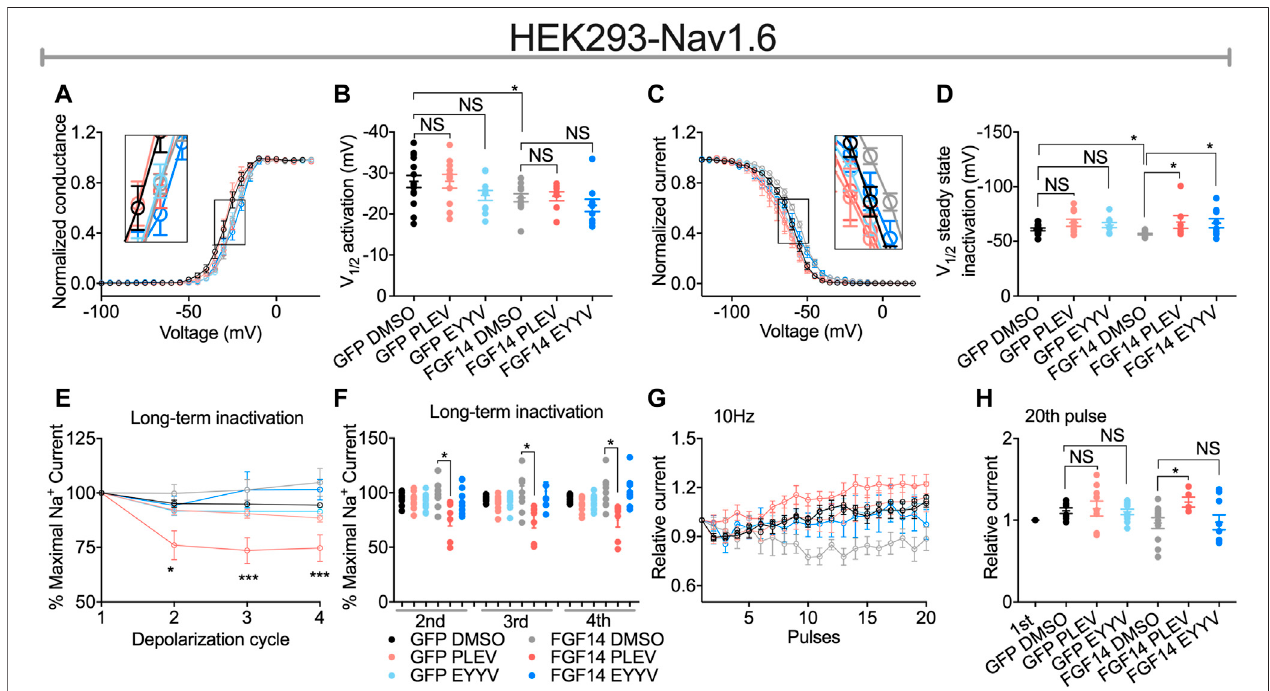
FIGURE 4 | Functional regulation of Nav1.6-mediated currents by PLEV and EYYV. (A) Conductance-voltage relationships for Nav1.6 cells co-expressing GFP or FGF14-GFP treated with 0.1% DMSO, 50 µM PLEV and 50 µM EYYV. (B) Comparison of V1/2 of activation between the indicated experimental groups. (C) Normalized currentasafunctionofmembranepotentialtocharacterizetheeffectsof0.1%DMSO,50 µMPLEV,and50 µMEYYVonsteady-stateinactivation. (D) ComparisonofV1/2of steady-state inactivation between the indicated experimental groups. (E) Ratio maximal INa plotted as a function of depolarization cycle to characterize the effects of 0.1%DMSO,50 µMPLEV,or50 µMEYYVonentryofNav1.6channelsintolong-terminactivation(LTI)inthepresenceandabsenceofFGF14.Cellsweresubjectedtofour 0 mV 16 ms depolarizations separated by − 90 mV 40 ms recovery intervals. (F) Bar graph represented 2nd, 3rd, and 4th pulse of LTI. (G,H) Characterization of cumulative inactivationofNav1.6channelsinthepresenceorabsenceofFGF14exposedto0.1%DMSO,50 µMPLEV,or50 µMEYYV.Itwasexaminedbyapplyinga2 mstestpulse to − 10 mV, 20 times at frequency10 Hz from a holding potential of − 80 mV. Data are mean ± SEM. Signi fi cance was assessed using a one-way ANOVA Tukey ’ s multiple